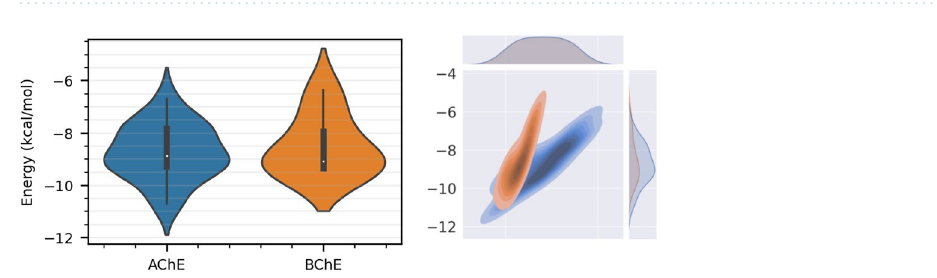
Figure 4. The IFD scores of compound 1 in different poses inside AChE and BChE – the minimum, maximum, first quartile, median, and third quartile values are presented (left panel). Probability density function of the IFD scores between the two systems are compared using KDE method (right panel). The AChE complex was represented with more varieties of the poses which lead to diverse binding energies, compared to the BChE complex. The lowest binding energies were calculated around − 12 and − 10 kcal/mol for the AChE and BChE complexes, respectively, demonstrating that AChE is more favourite for compound 1